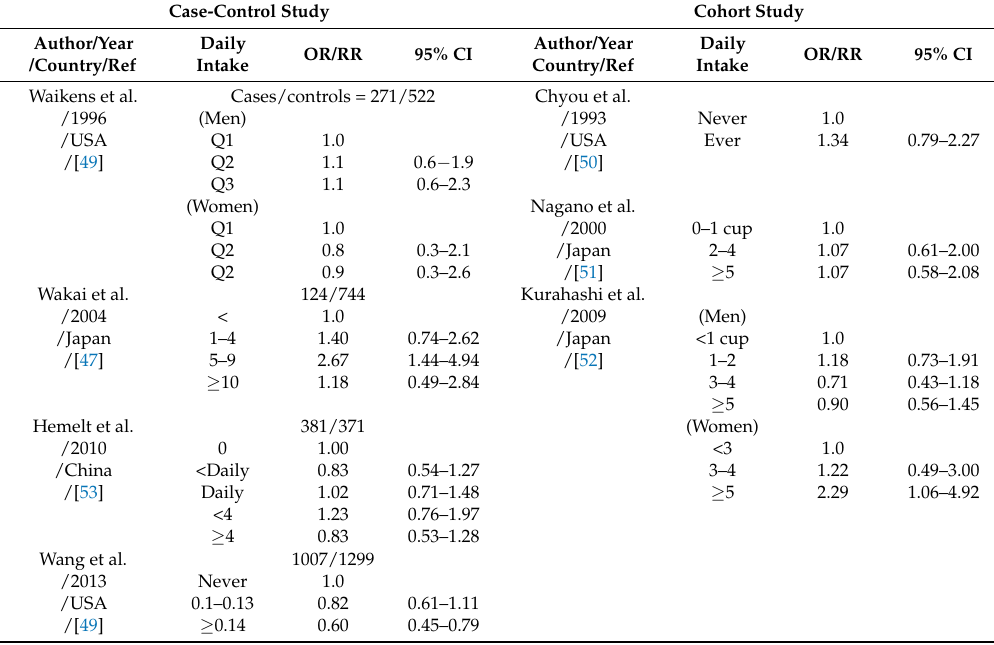
Table 1. Previous reports on the relationship between green tea consumption and bladder cancer